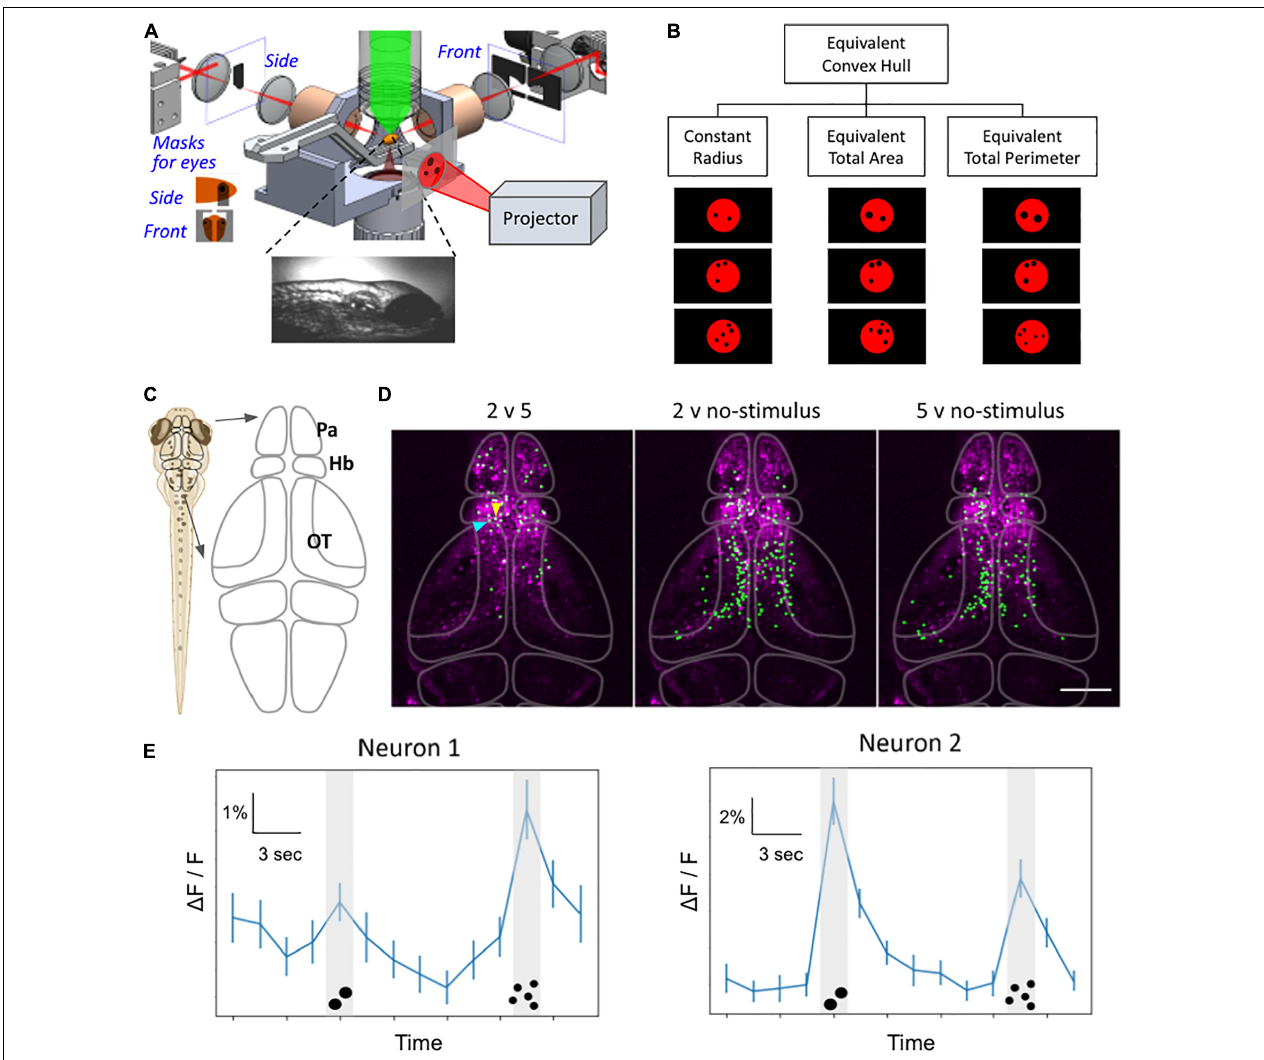
FIGURE 4 | Whole-brain functional imaging to find neural substrate of zebrafish numerosity capability. (A) Schematic setup of the 2p-SPIM setup that allows calcium imaging of awake zebrafish larvae that are subjected to visual numerosity stimuli. (B) Examples of the numerosity stimuli, which consist of a particular number of black dots on a diffuse red background. The visual patterns are controlled for various non-numerosity continuous variables to find the responses that are intrinsic to the recognition of discrete numbers. (C) Schematic drawing of the brain. The forebrain includes the pallium (Pa) and the habenula (Hb). The midbrain contains the optic tectum (OT). (D) Representative results from 8-dpf larvae show neurons that exhibited different levels of activity during different stimuli (e.g., 2 versus 5 dots, etc.). Green: nuclei of identified neurons. Magenta: anatomical background generated via the maximum-intensity projection in Z of the standard deviation projection in time, depicting neurons with time-varying activity. The raw dataset covers the volume of ∼ 350 µ m × 600 µ m × 250 µ m (depth), taken with three sections per volume for 42 min. (E) Representative activity traces, of the two neurons selected by arrowheads in panel (D) , during number stimuli. The line graph depicts activity levels as (cid:49) F/F for the time trial as shown, averaged over n = 50 trials. Neuron 1 (blue arrowhead): higher activity levels during the 5-dot stimuli compared to the 2-dot stimuli. Neuron 2 (yellow arrowhead): higher activity levels during the 2-dot stimuli compared to the 5-dot stimuli. P < 0.05, bootstrapping with resampling. Error bars represent SEM, n = 50. Scale bar in panel (D) ,100 µ